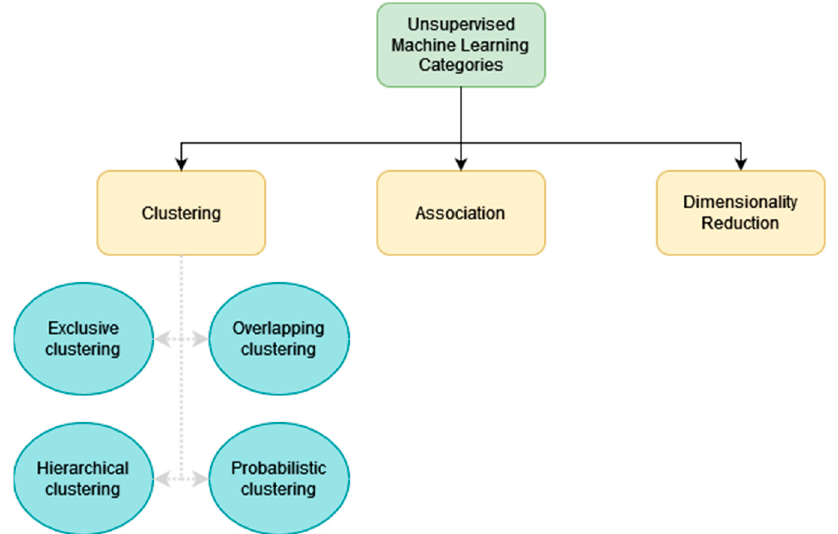
Figure 3. Unsupervised Machine Learning Categories.